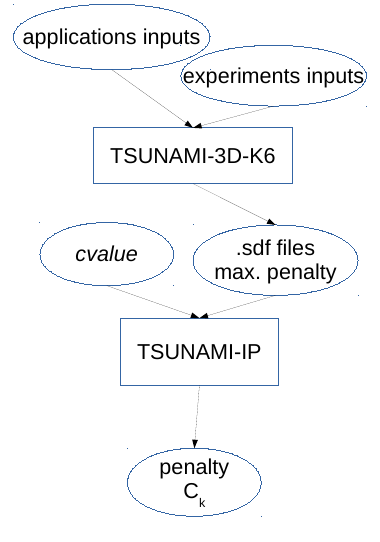
Figure 1. Diagram of evaluation process using